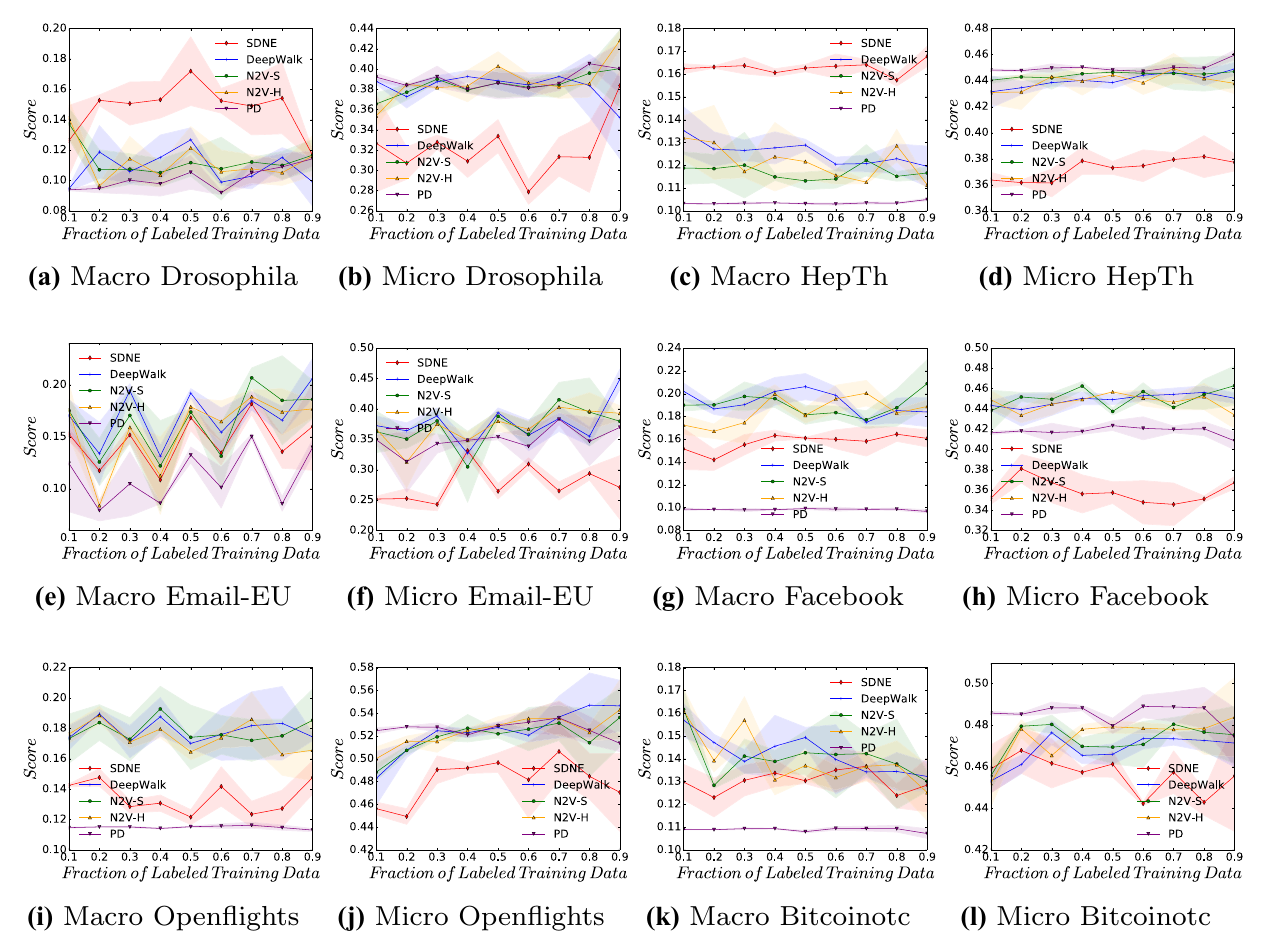
Fig. 8 Micro-f1 and macro-f1 scores, across a range of labelling fractions, for all approaches when predicting a vertex’s betweenness centrality (BC) value across all datasets